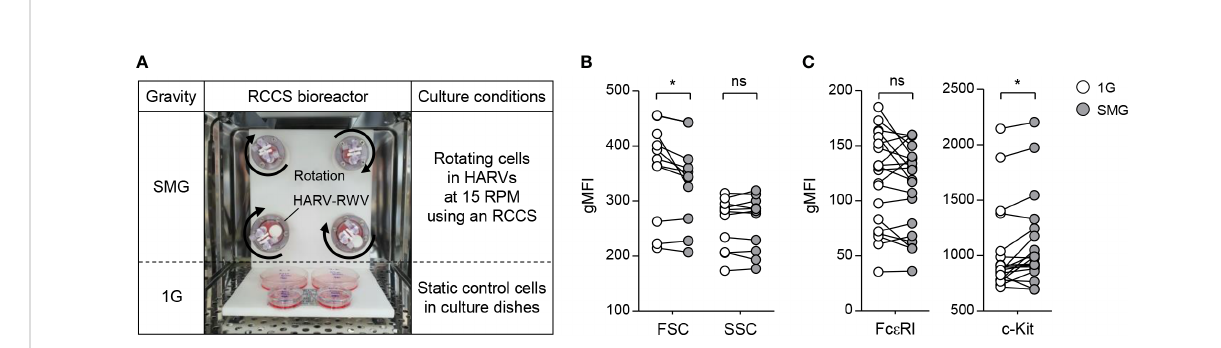
FIGURE 1 Effects of SMG on mast cell size, granularity, and surface expression of Fc e RI and c-Kit. (A) BMMCs were cultured in HARV-RWVs of RCCS to simulate microgravity conditions or in static dishes under normal gravity (1G) controls. Round arrows indicate rotation. (B) Cell size and granularity were determined by geometric mean fl uorescence intensity (gMFI) analyses of forward scatter (FSC) and side scatter (SSC) using fl ow cytometry after 48 h of SMG exposure, respectively (n = 11). (C) Scatter graphs represented surface expression of Fc e RI and c-Kit on BMMCs after 48 h of SMG exposure. IgE-loaded cells were stained with PE-conjugated c-Kit and FITC-conjugated IgE antibodies (n = 20). Paired, two- tailed student ’ s t-test was performed to detect the statistical signi fi cance (*p < 0.05). ns, not signi fi